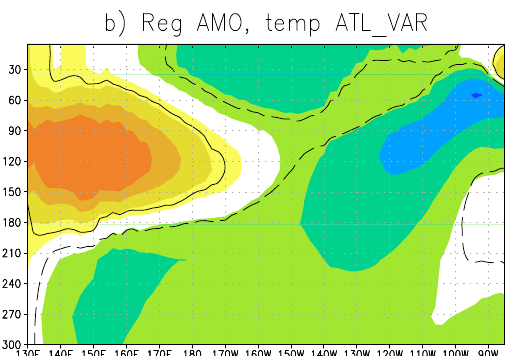
Figure 12. Regression of ( a ) observed; ( b ) ATL_VAR temperature near the equator (averaged from 5 ◦ S to 5 ◦ N) onto the AMO index. In (b), anomalies that are 95% statistically significant are indicated by contours. Units are